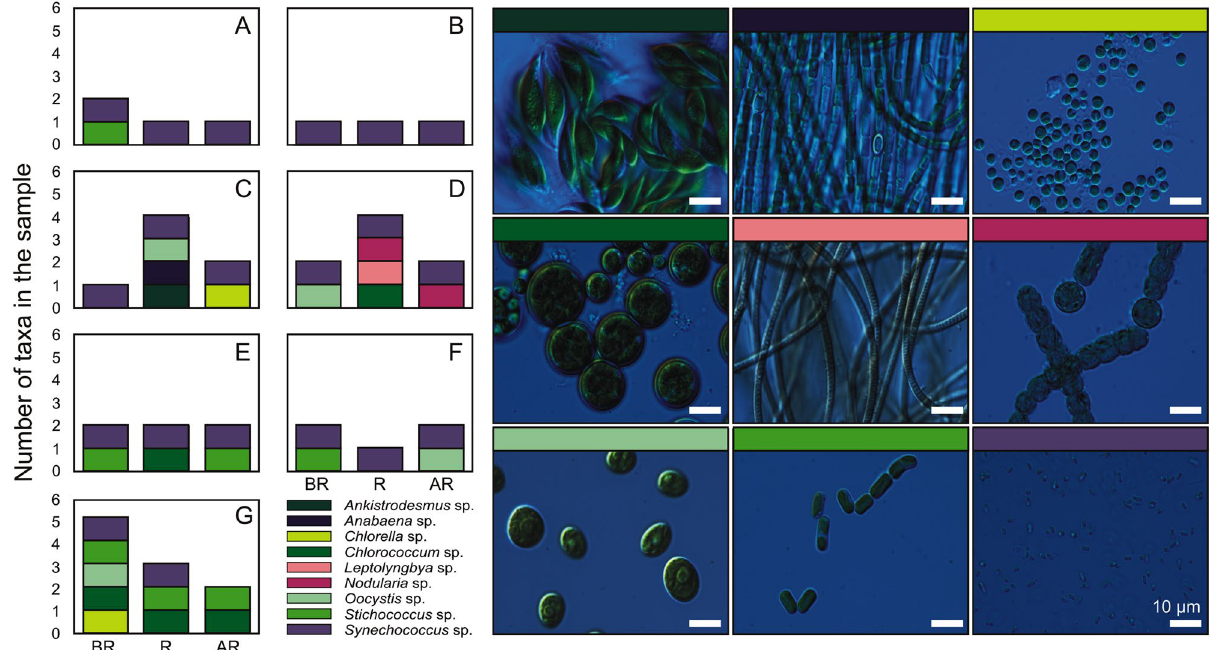
Figure 3. Number of microalgae and cyanobacteria cells in air samples before (BR) and after rainfall (AR) and in rainwater samples (R) on the morning of August 25, 2020 ( A ), the afternoon of August 25, 2020 ( B ), on August 26, 2020 ( C ), at noon on August 27, 2020 ( D ), in the evening on August 27, 2020 ( E ), on August 28, 2020 ( F ), from August 30 to September 1, 2020 (including 2 d of rainfall) ( G ) (left panel), and examples of microalgae and cyanobacteria collected from dry and wet deposition samples (right